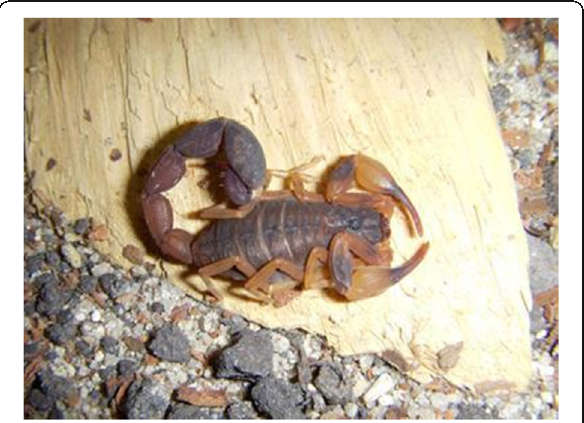
Fig. 2 Tityus bahiensis. Known as the brown scorpion, T. bahiensis has a dark trunk, legs and palps with dark spots and reddish brown tail.